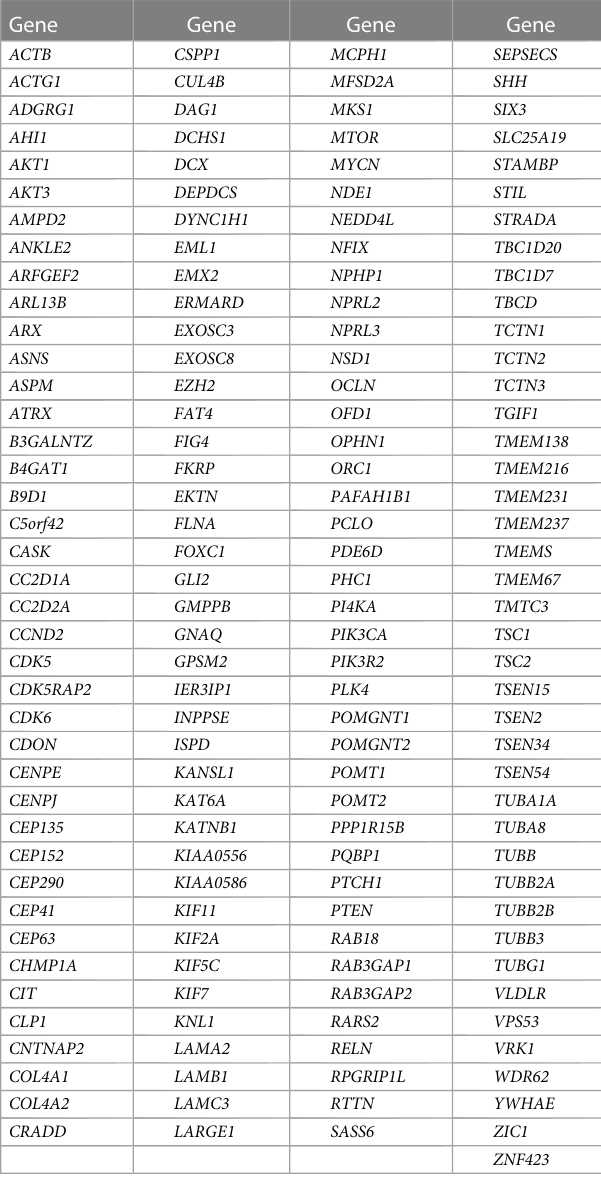
TABLE 1 A list of the 161 genes included in the NGS panel for brain malformations searched in our patient.